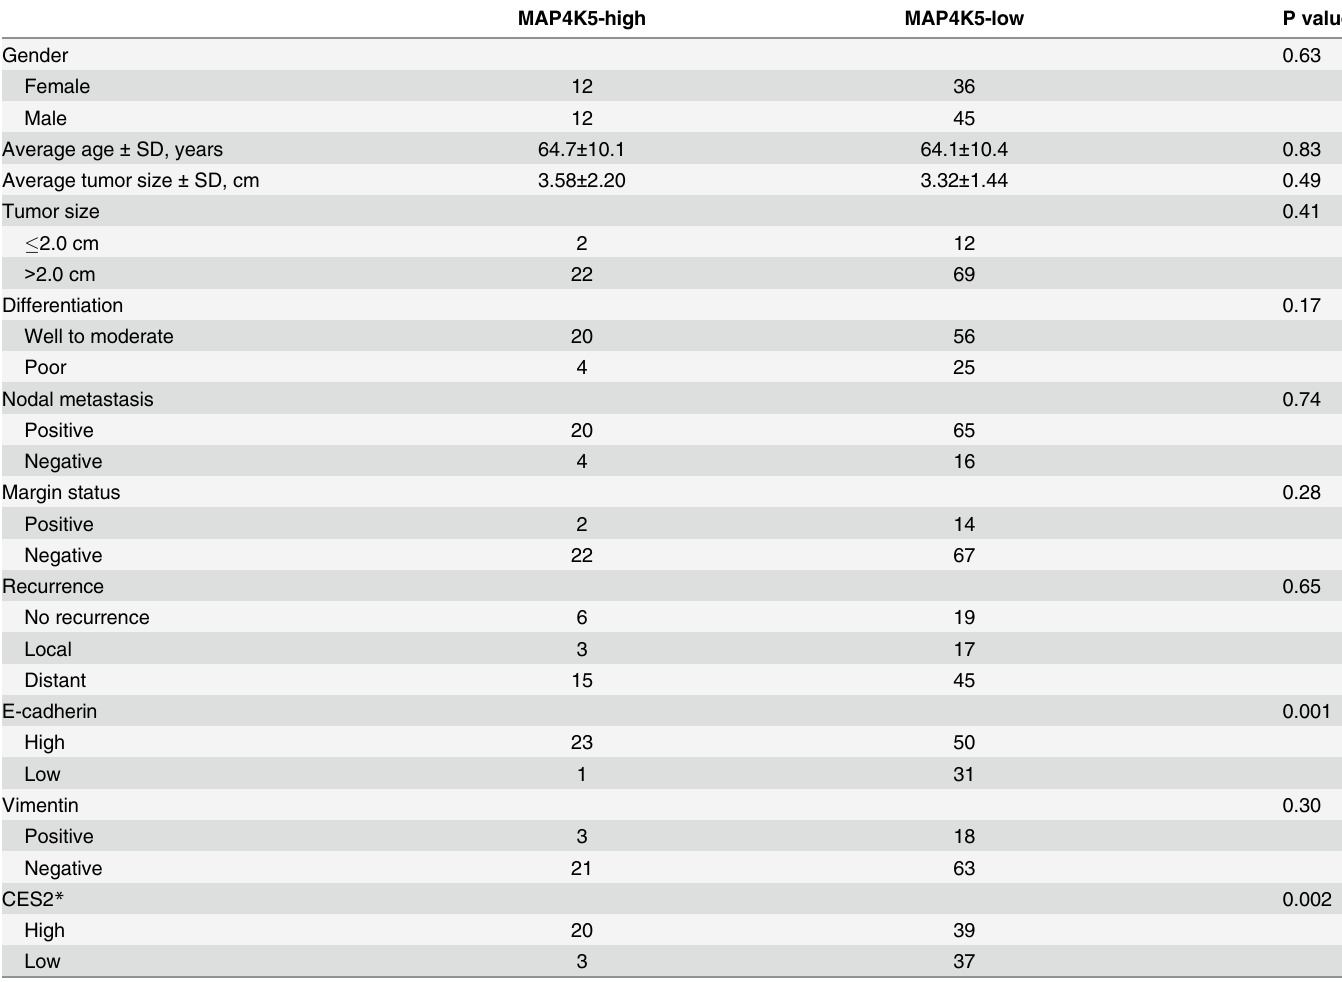
Table 2. Correlations of MAP4K5 Expression with Clinicopathologic Parameters And Other Molecular Markers in Pancreatic